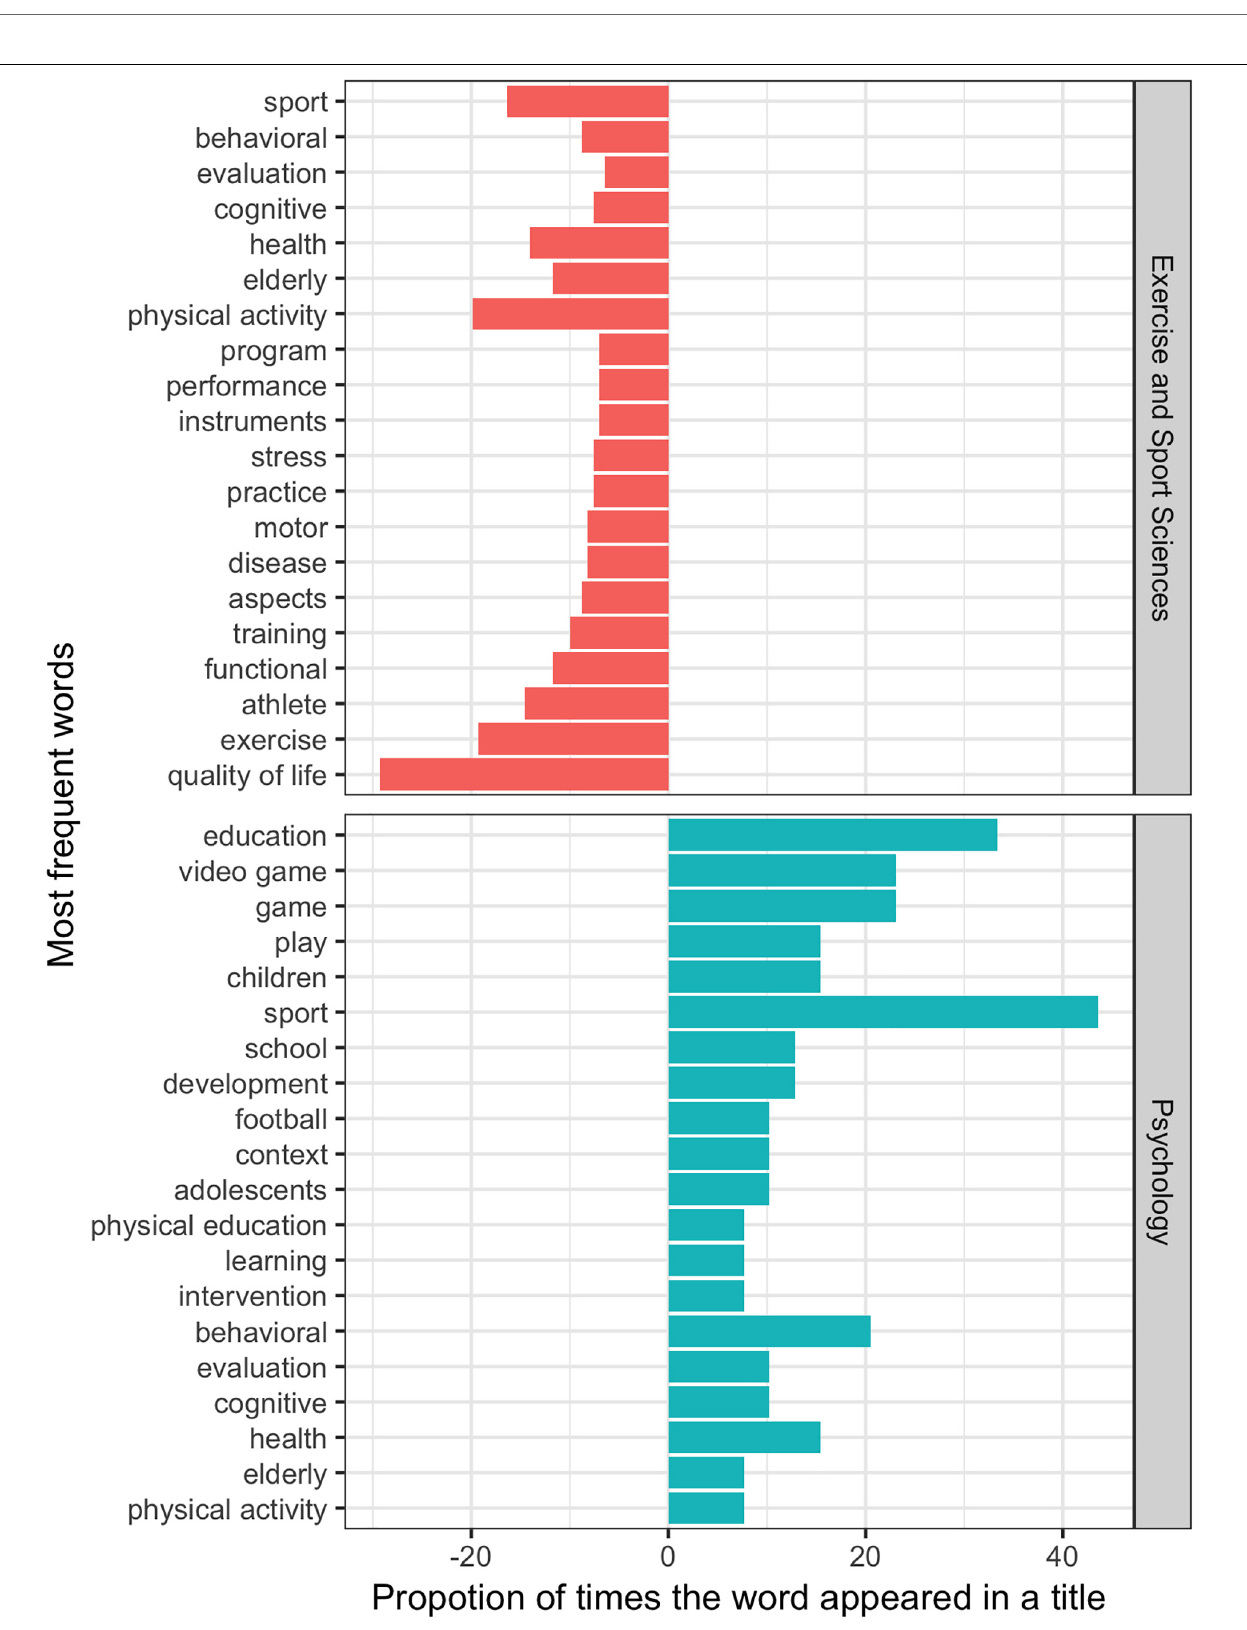
Frontiers in Psychology |